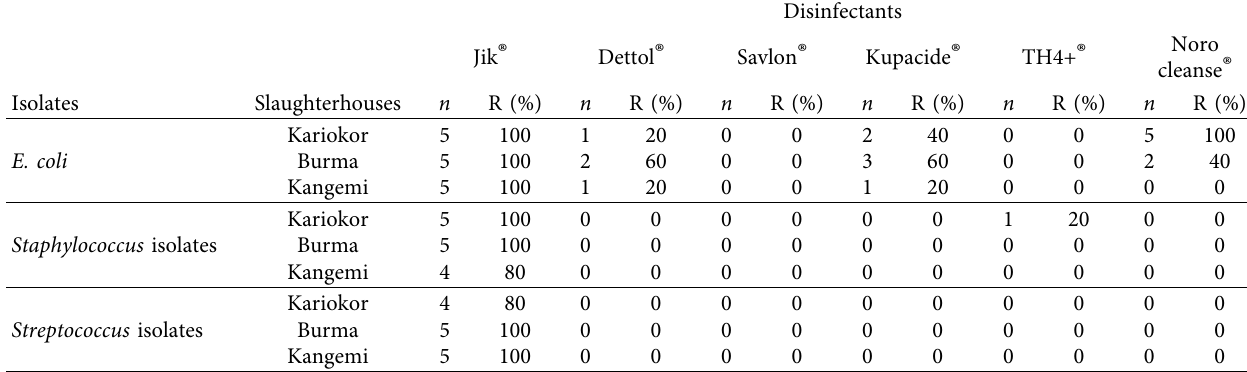
Table 2: Percent resistance of the tested isolates at recommended user concentration, for n � 5.